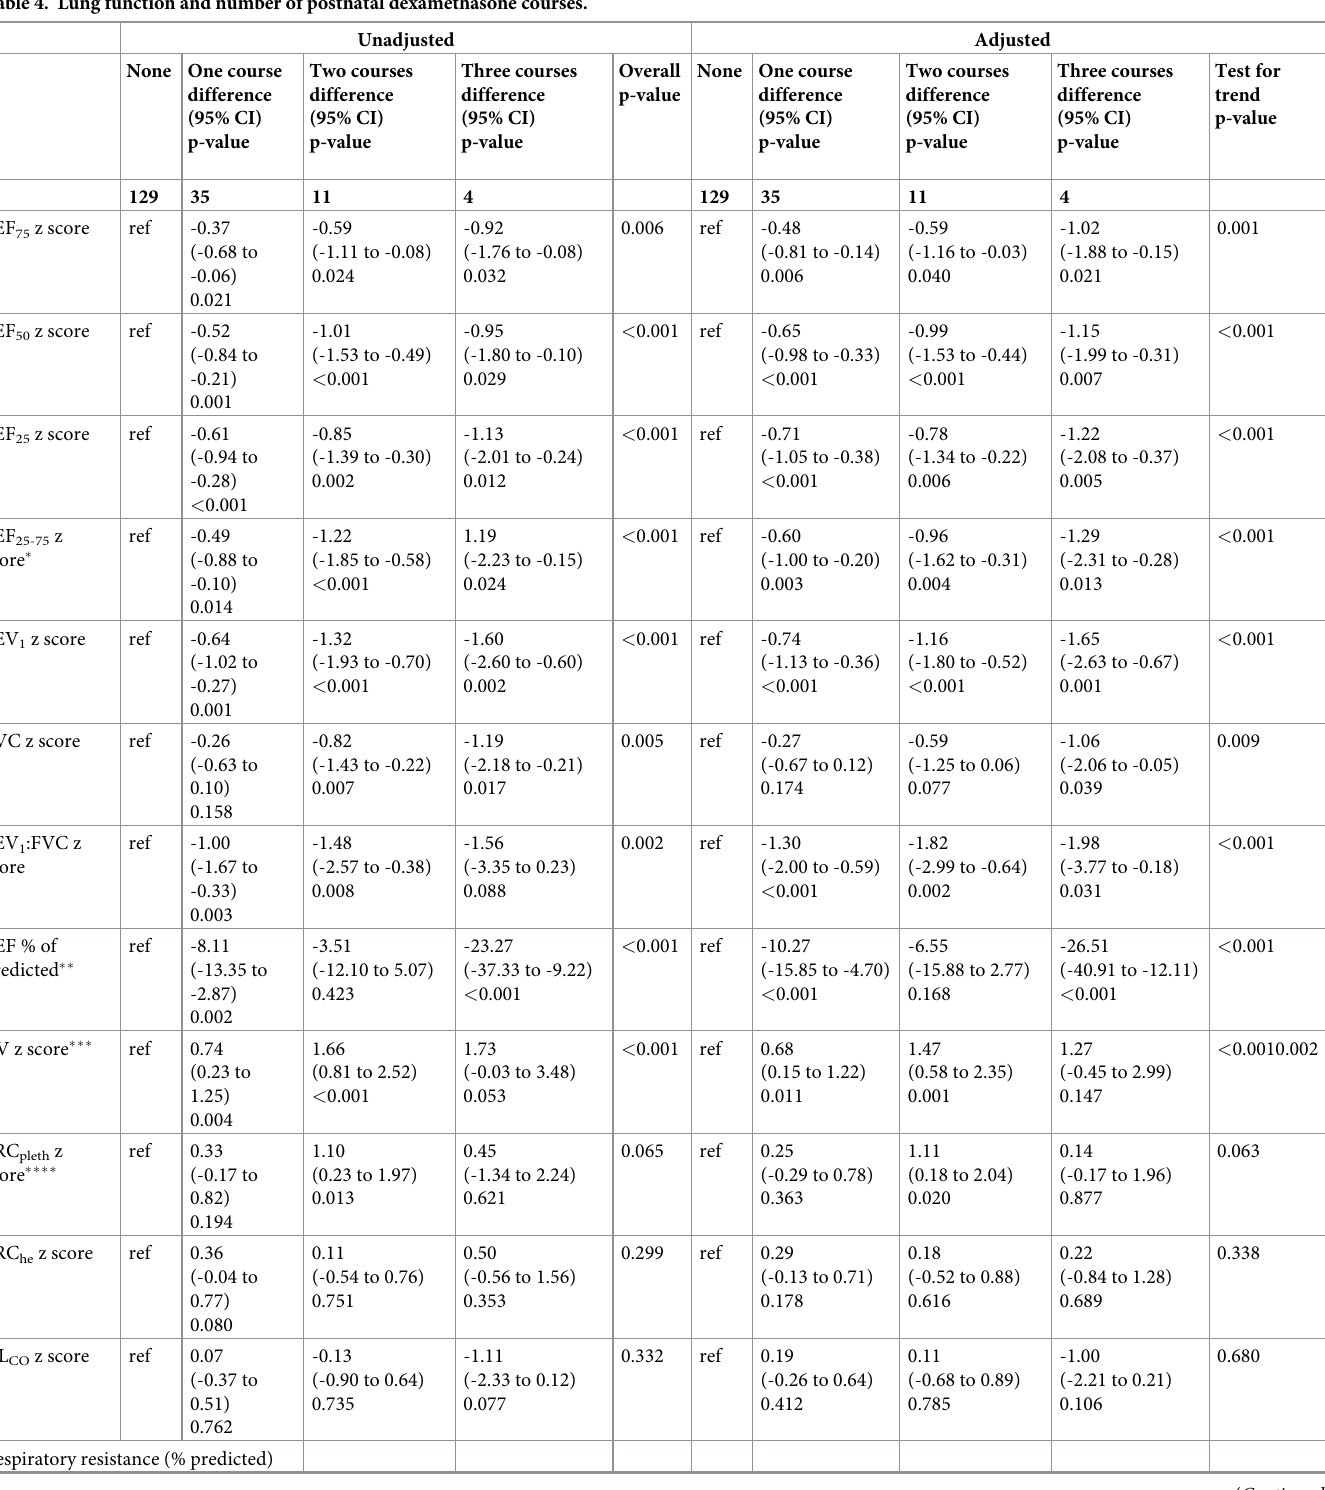
Table 4. Lung function and number of postnatal dexamethasone courses. Unadjusted